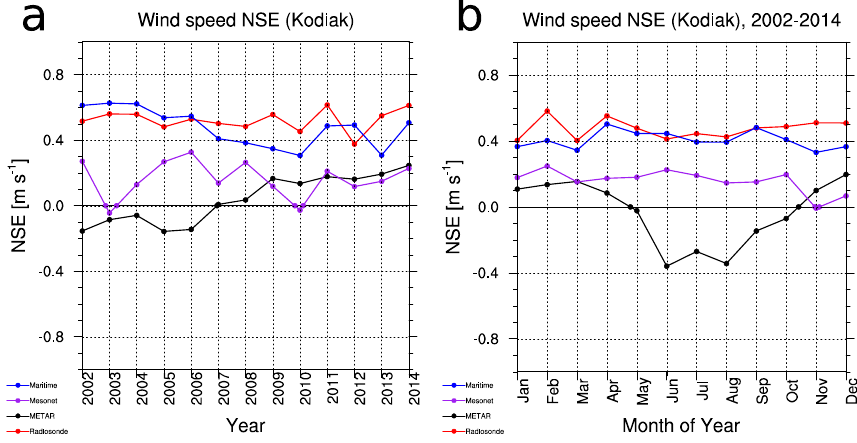
Figure 18. As in Figure 10, but for the Nash-Sutcliffe efficiency over the Kodiak region only.